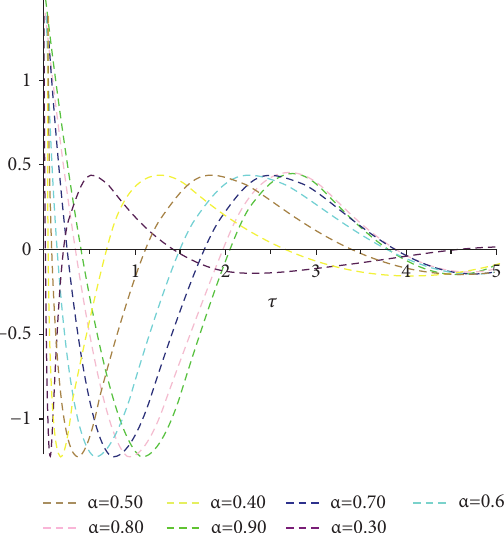
Figure 2: 2D with the real part of solution Ψ